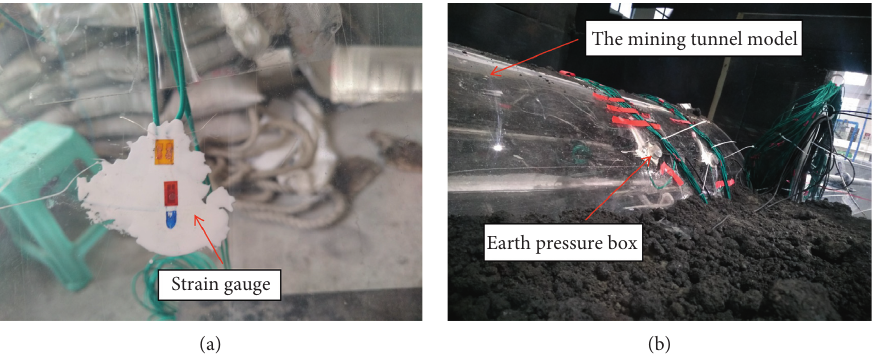
Figure 9: Strain gauge and earth pressure box arrangement.